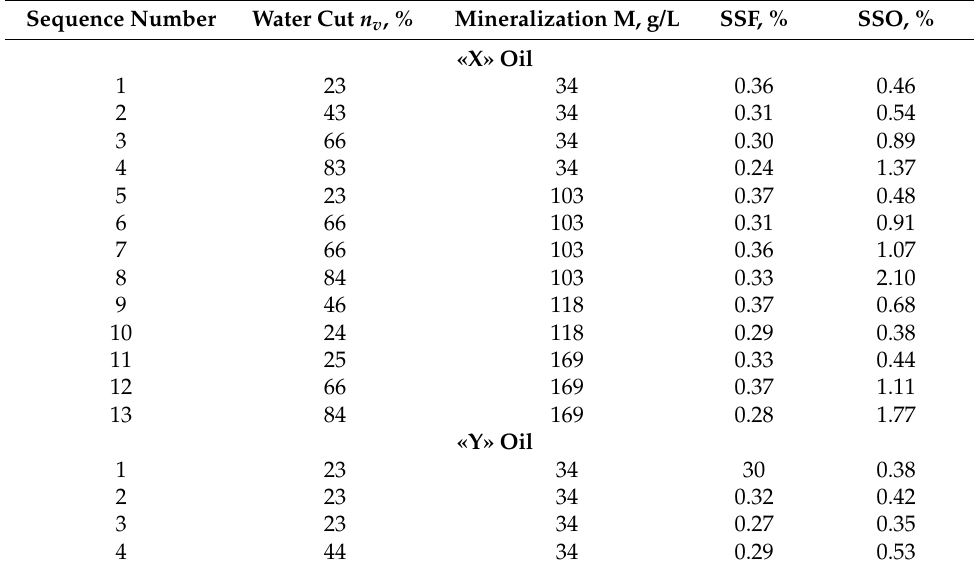
Table 3. Results of laboratory